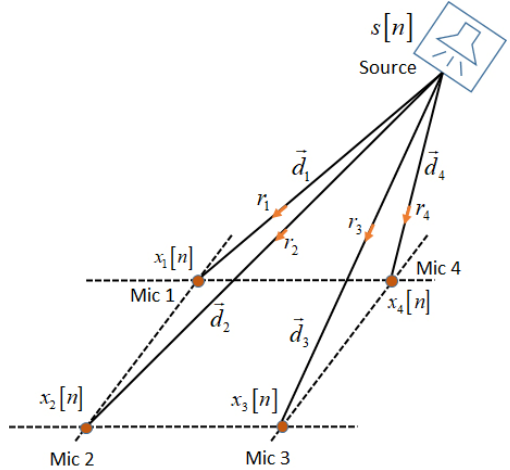
Figure 1. The near-field model for sound signal propagation in sound source localization (SSL) algorithms.